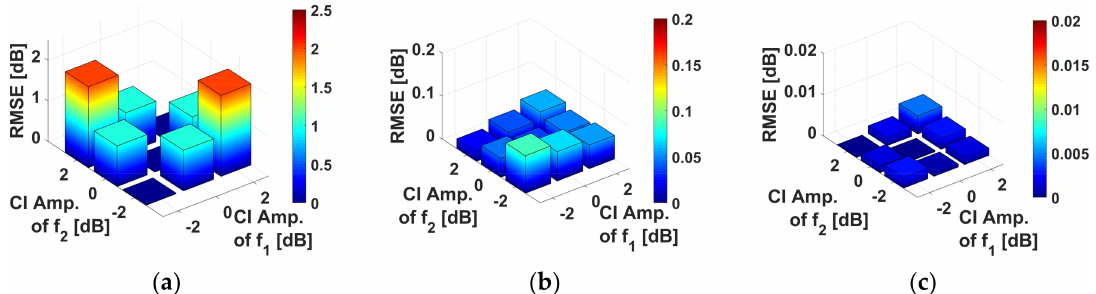
Figure 3. RMSE of channel imbalance estimation for imbalances amplitude variability using simulation data obtained by ( a ) the Van Zyl method, ( b ) the Quegan method and ( c ) the Villa method. Note that the vertical axes have different scales.